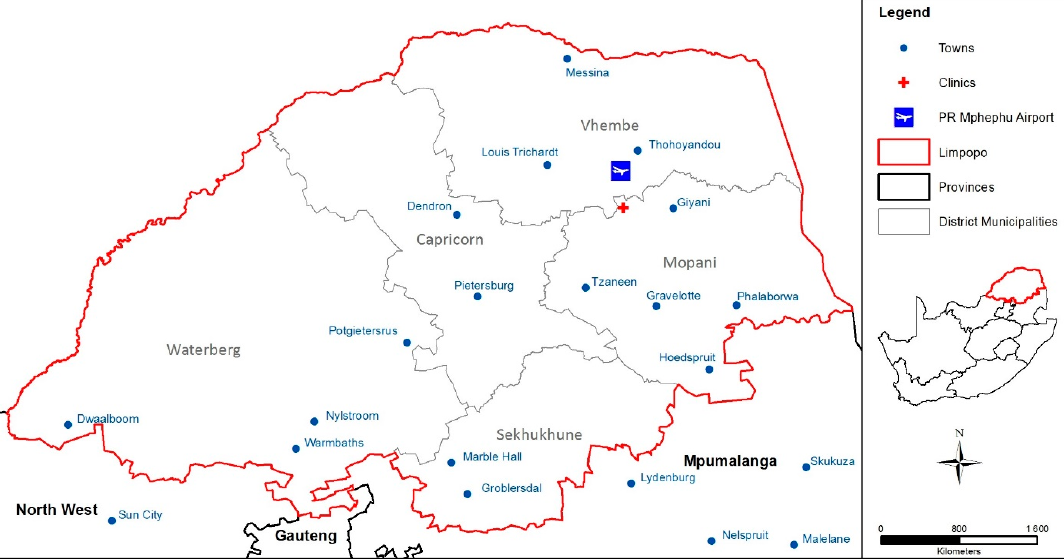
Figure 1. Map showing the location of Mopani District in Limpopo Province, South Africa (map produced in-house using geographic information system (GIS) software ArcGIS [18]).